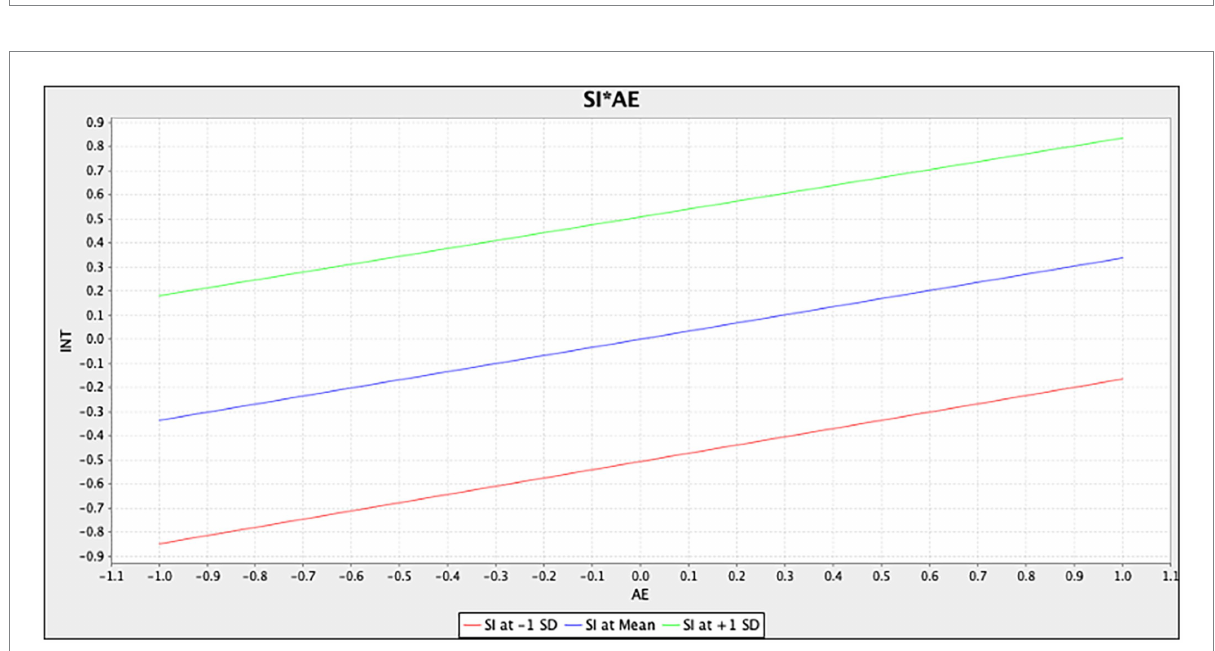
FIGURE 4 Moderating effect of situational involvement on the relationship affective experience and behavioral